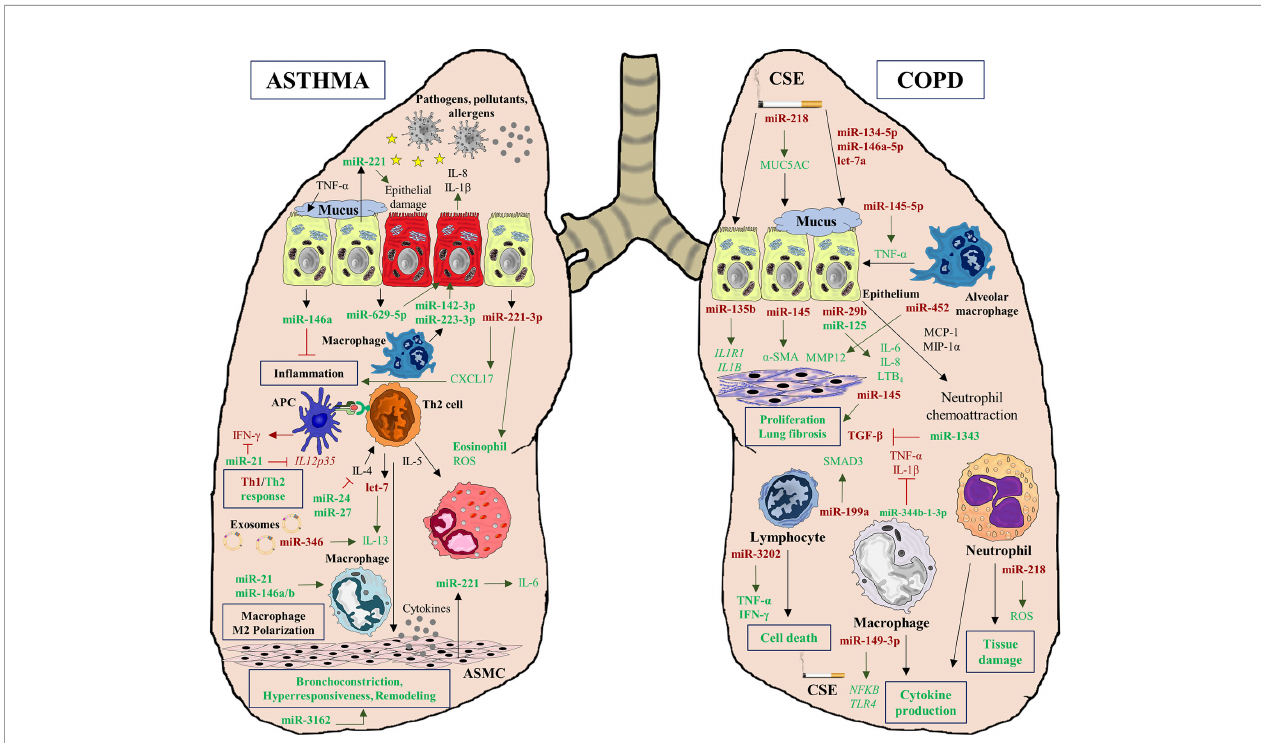
FIGURE 2 | MiRNA interactions in asthma and COPD diseases. MiRNAs play a crucial role, regulating multiples processes characteristics of both pathologies. In asthma, deregulation of multiples miRNAs affects to in fl ammatory processes (miR-221-3p), Th1/Th2 response imbalance (miR-21), cytokine production (miR-629-5p, miR-142-3p, and miR-223-3p), epithelial injury (miR-221), macrophage polarization to M2 phenotype (miR-146a/b, miR-21) and airway remodeling (miR-3162). However, miRNAs also can alleviate in fl ammation (miR-146a) and cytokine decrease production (miR-24 and miR-27). In COPD pathogenesis, miRNAs can be altered by CSE exposition and they are involved in mucus hypersecretion (miR-218) and cytokine production (miR-149-3p). Moreover, several deregulated miRNAs are implicated in lung fi brosis (miR-135b, miR-145, and miR-452), and in tissue damage (miR-218). Similarly to asthma, in COPD some miRNAs can act as regulators of in fl ammation decreasing the secretion of several cytokines such as TGF- b (miR-1343), TNF- a , and IL-1 b